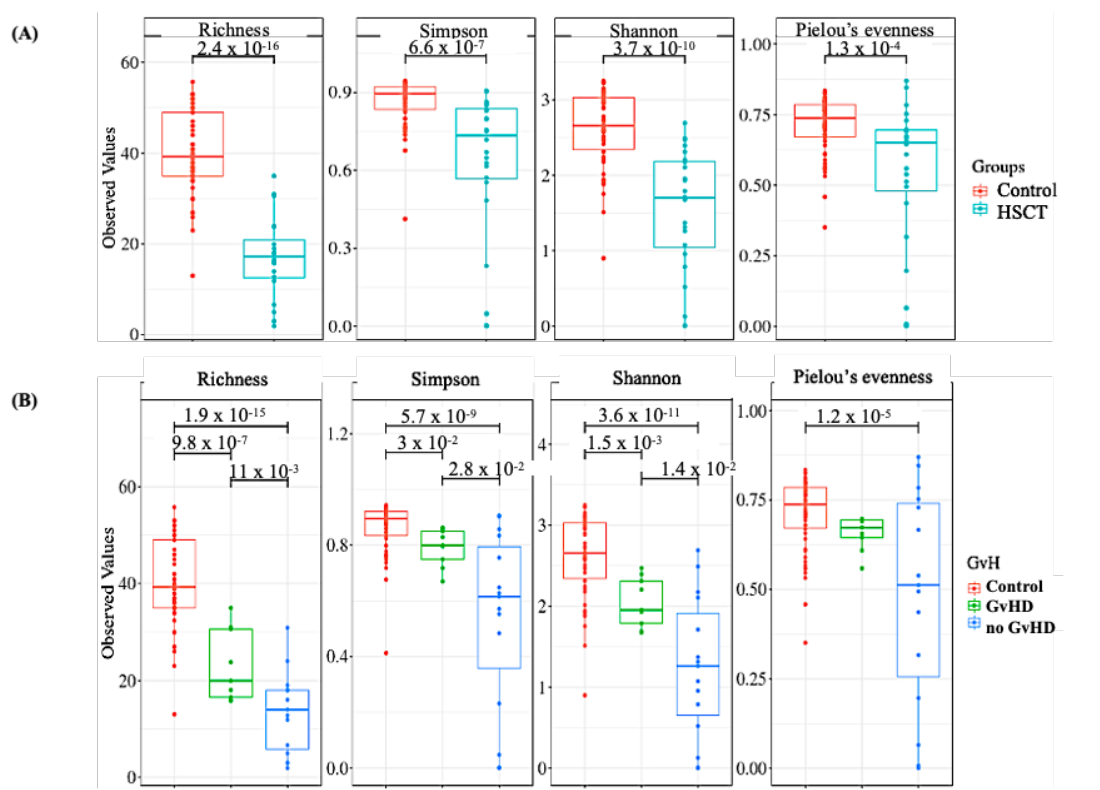
Figure 2. Boxplots of OTU’s richness, Simpson, Shannon, and Pielou’s evenness diversity indexes distinguishing between the hematopoietic stem cell transplant group (allo-HSCT group) and the control group. Statistical analysis was performed with the Wilcoxon rank-sum test. ( A ) Alpha diversity indexes within the control ( n = 18) and the allo-HSCT group ( n = 15). ( B ) Alpha diversity analysis among allo-HSCT patients’ richness and diversity indexes within patients with and without graft-versus-host disease (GvHD and no GvHD, respectively) groups ( n = 4 and n = 11, respectively). Study groups are statistically different ( p -value < 0.05; Wilcoxon rank-sum test).